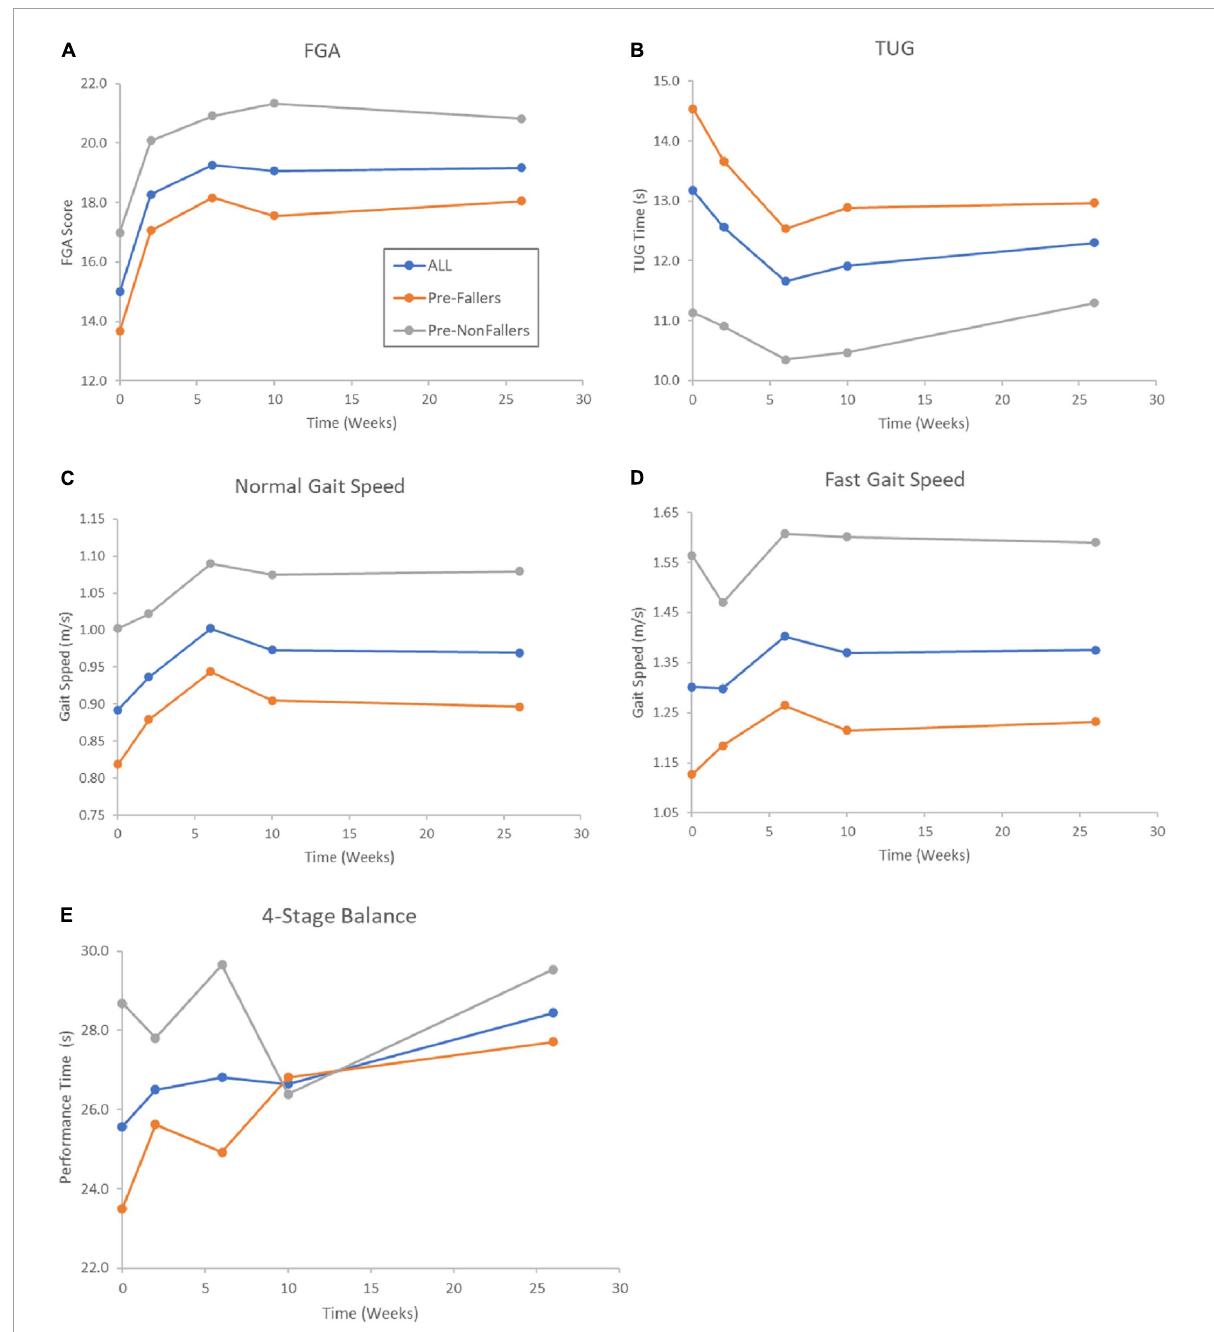
FIGURE4 Averages of clinical outcomes across the in-person assessments at baseline (0), 2, 6, 10, and 26 weeks for the 30 participants (blue lines and symbols) who were able to be tested in clinic after 26 weeks of device use for the in-clinic outcomes FGA (A) , TUG (B) , gait speed (C,D) , and the Four-Stage Balance test (E) . Gray symbols and lines represent the pre-study non-fallers ( n = 12 of 30) and orange lines and symbols represent pre-study fallers ( n = 18 of 30). Notice that most improvements appeared to peak after 6–10 weeks of device use, followed by a leveling off until 26